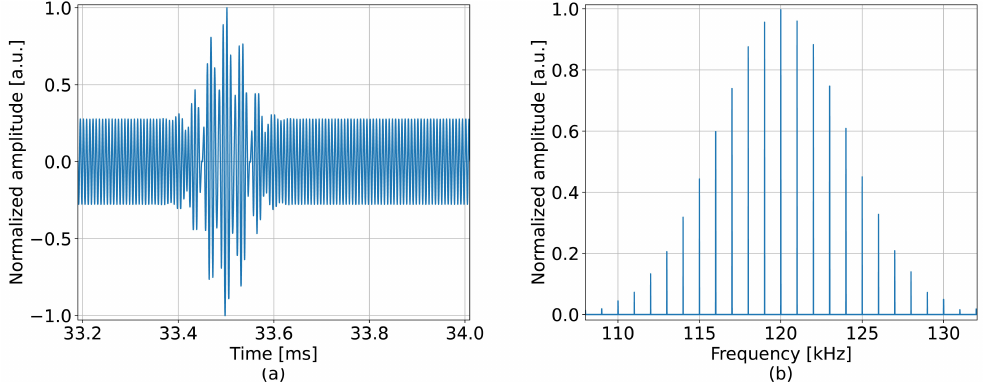
Figure 5. Perturbation of increased complexity applied experimentally ( a ) in the time domain; ( b ) in the frequency domain.